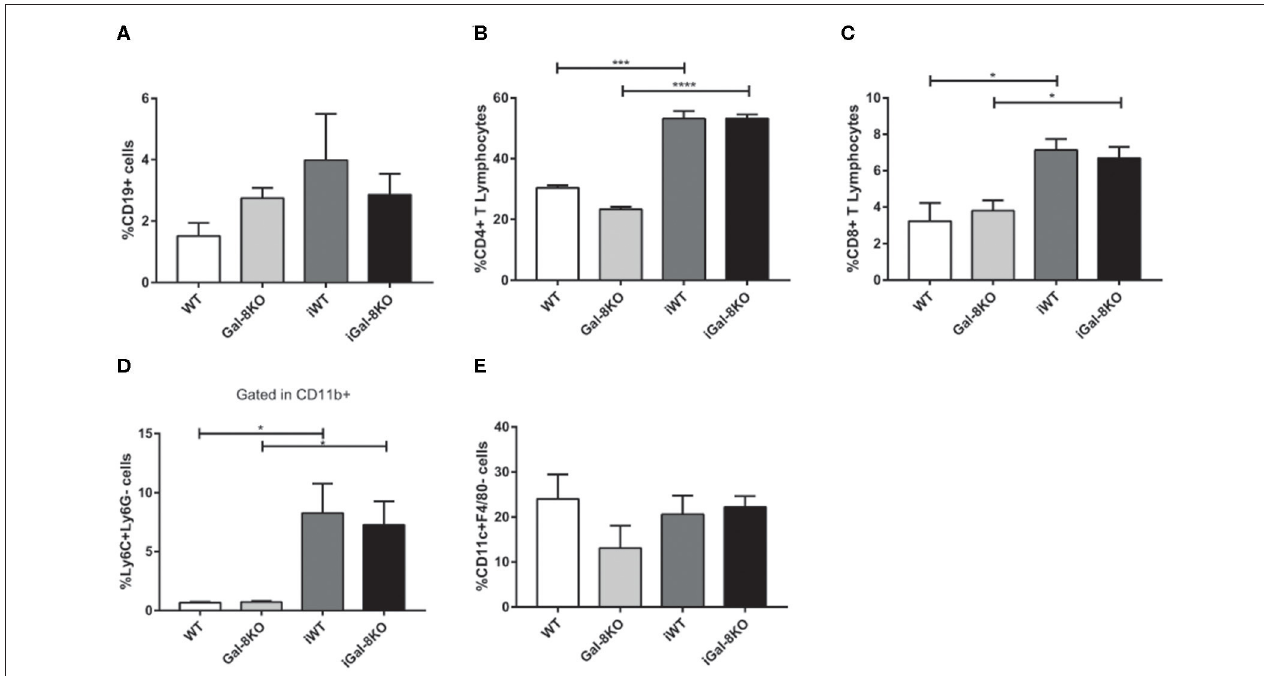
FIGURE 4 | Phenotype of immune cells infiltrating chronic infected hearts. Immune cells were recovered from iWT and iGal-8KO mice heart tissues at 4–5 mpi and analyzed by flow cytometry. (A) Percentage of CD19 + B lymphocytes, (B) percentage of CD4 + T lymphocytes and (C) CD8 + T lymphocytes, and (D) percentage of CD11b + Ly6C + Ly6G– monocytes. (E) Percentage of CD11c + F4/80– dendritic cells. Results are expressed as mean ± SEM cells obtained in at least three independent experiments (5 animals/group). * P < 0.05; *** P < 0.001; **** P <